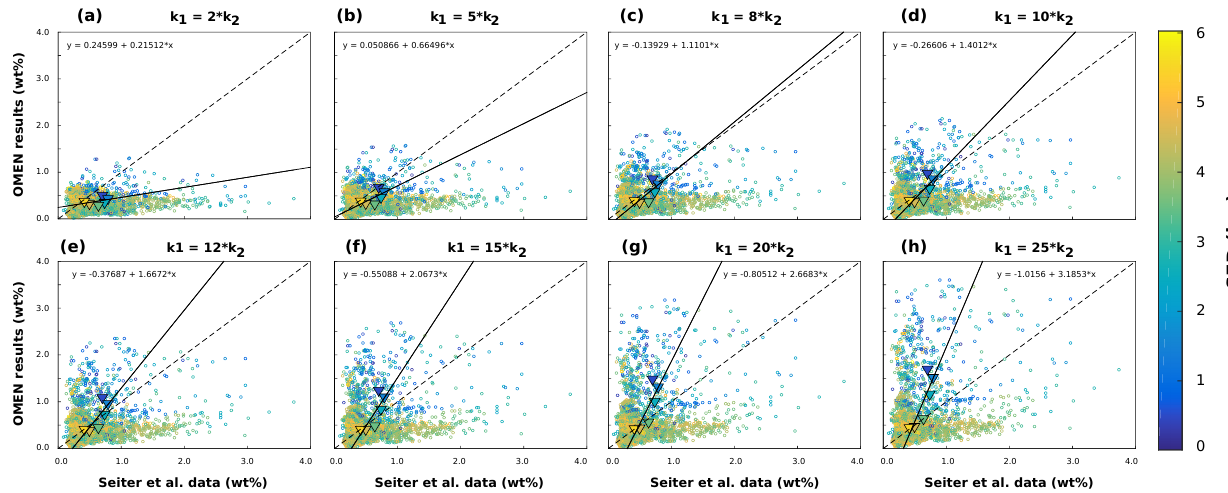
Figure 12. Cross plots comparing modelled and observed mean POC wt% in the upper 5cm of the sediments using the relationship of Boudreau (1997) and the assumptions of Eqs. (54) and (55) to calculate k 1 and k 2 . Data points are binned into six uniform depth classes of 1000m, and each class is represented by a triangle. Grid points with more than 4.0 POC wt% are not